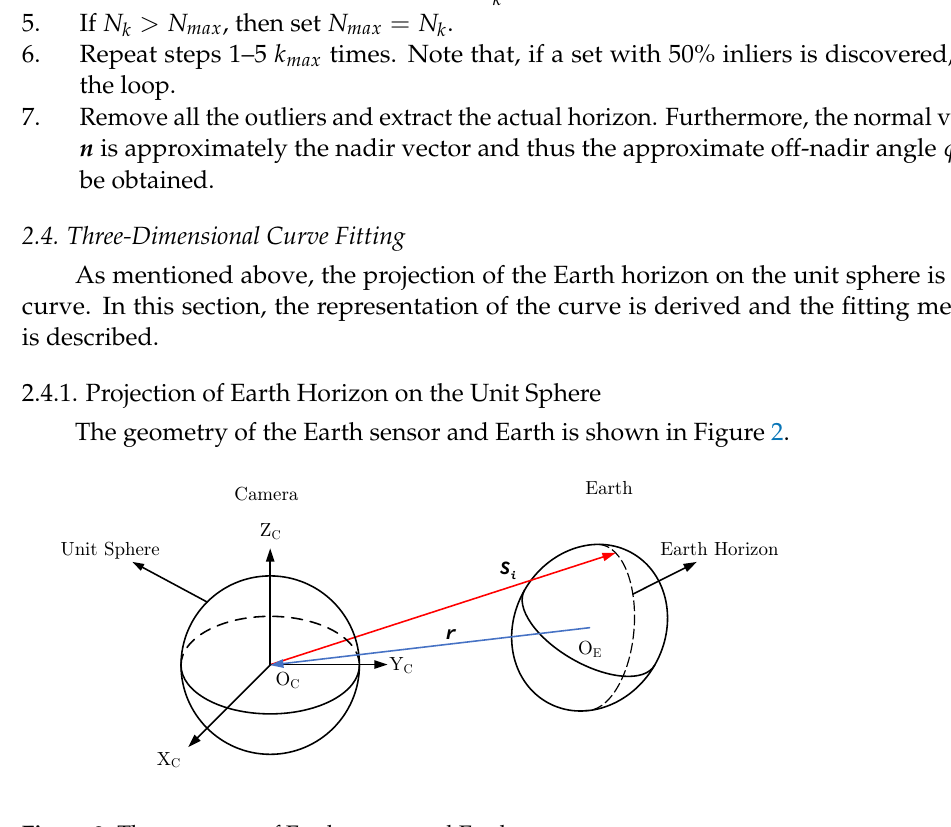
Figure 2. The geometry of Earth sensor and